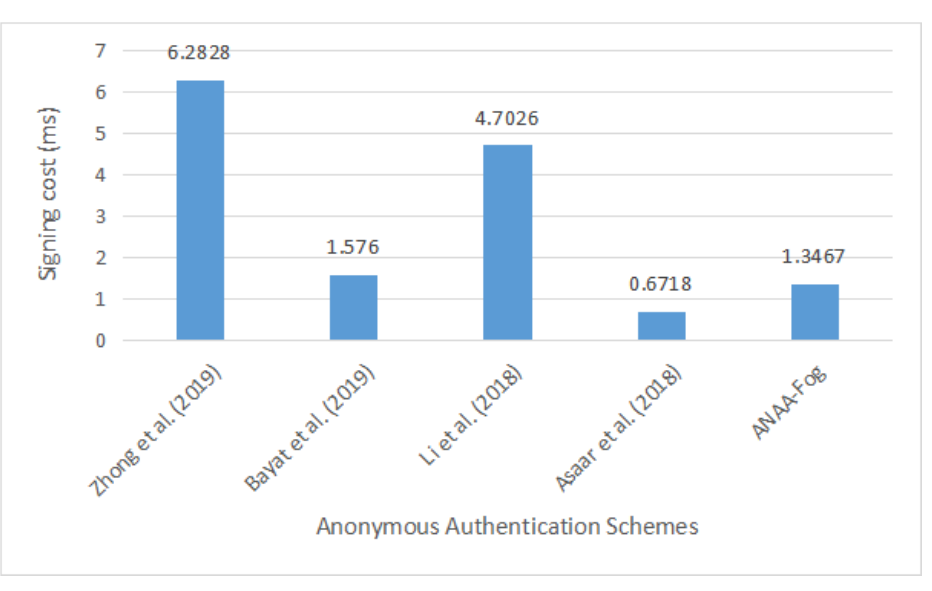
Figure 5. Single-message signing’s computational burden.